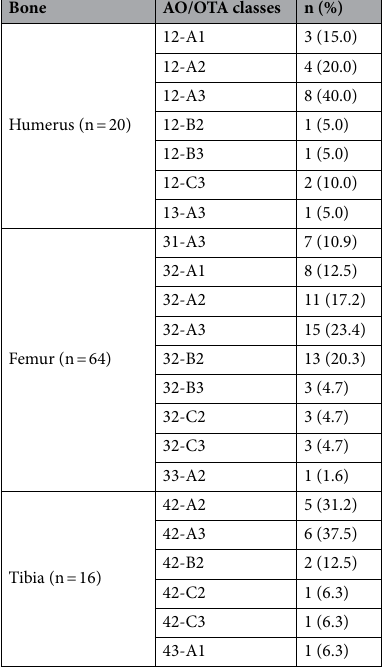
Table 2. AO/OTA classification of the fractures.